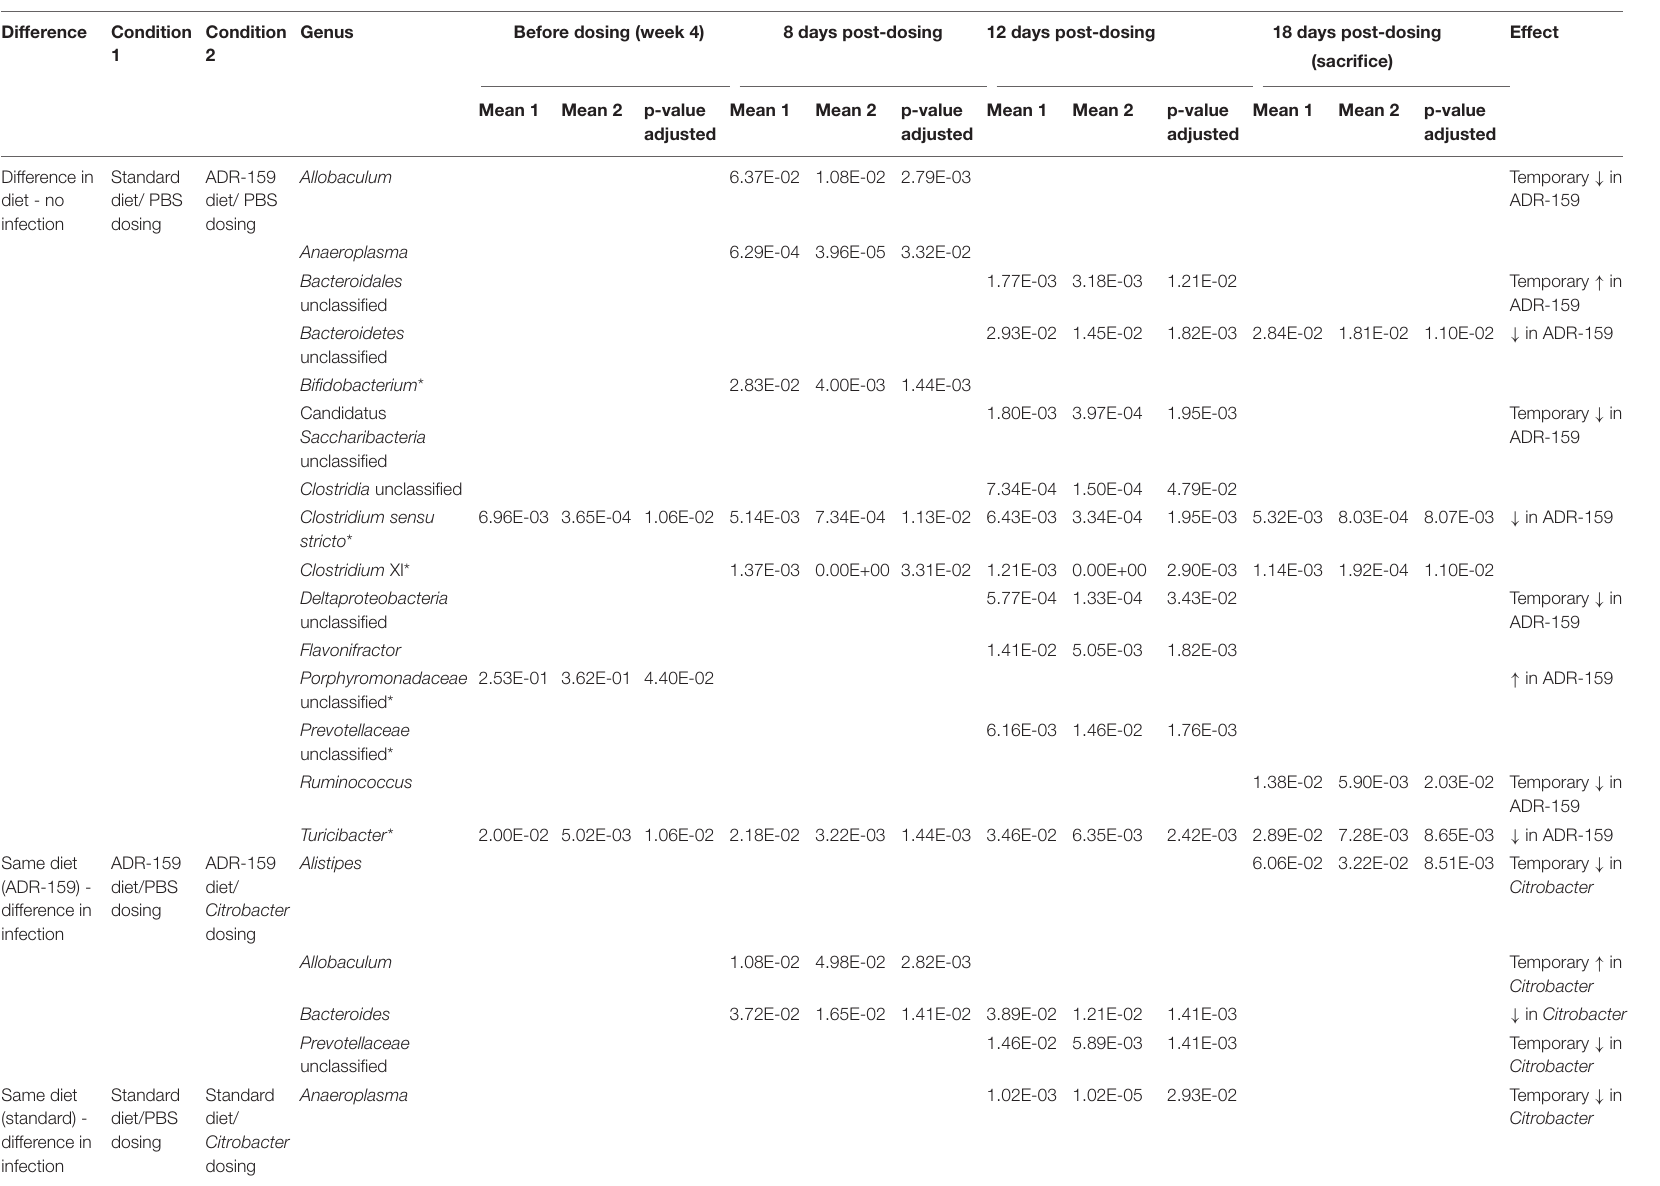
TABLE 2 | Genera differently abundant before and 8, 12, and 18 days post-initial dosing with PBS (A, C) and Citrobacter (B, D) of standard (A, B), and ADR-159 (C, D) fed animals. Difference Condition